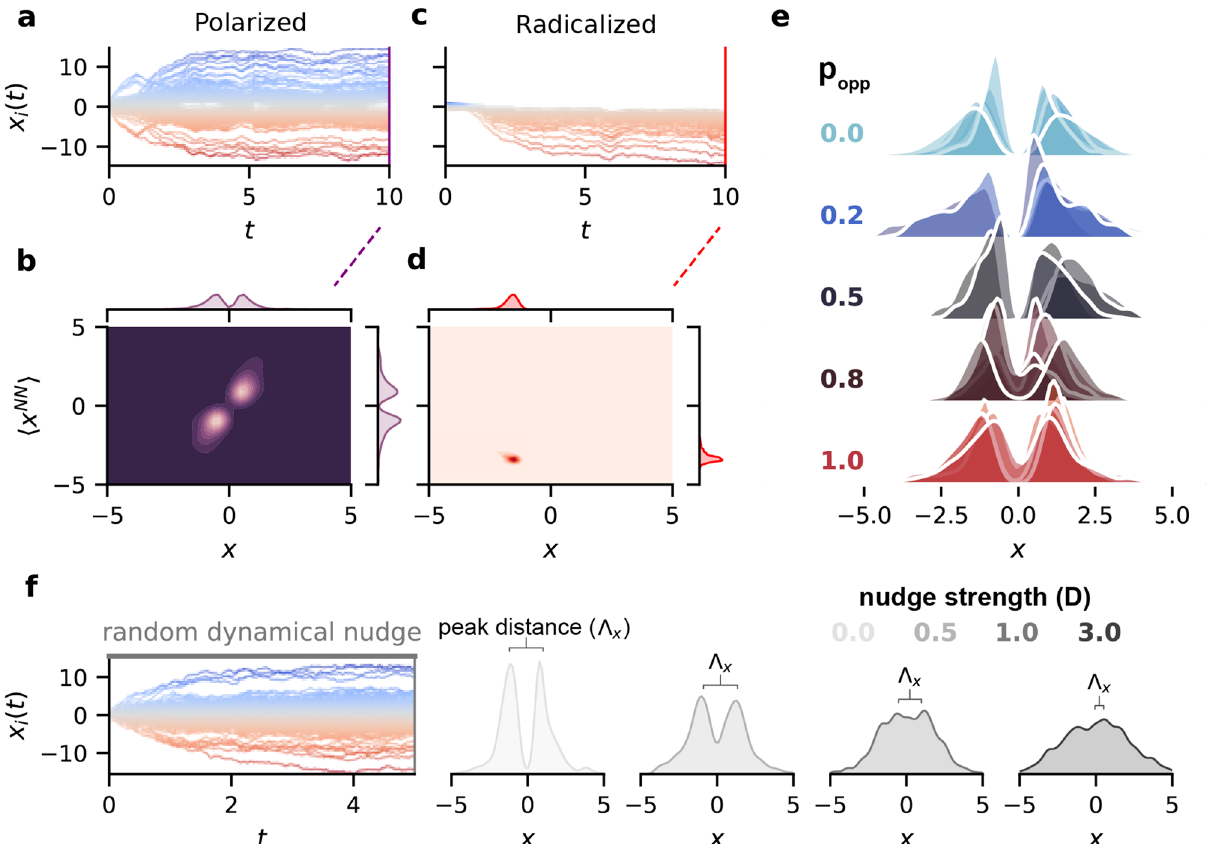
Figure 1. Adding a random dynamical nudge prevents a network from becoming polarized. The time traces 1000 agents for ( a ) polarized ( β 10 , heat maps of 3 ) and ( c ) radicalized ( β 0 ) states. ( b , d ) At t of N = = = = x NN agents’ opinions versus mean of agents’ nearest neighbours ( ) to indicate the formation of echo chambers (cid:31) (cid:30) agents interact with other agents who have similar opinions and the resulting bimodal distribution of opinions for polarized networks. ( e ) p opp represents the probability of randomly flipping the homophily factor ( β ) to instead interact more with those holding opposite opinions. p opp did not appear to be effective and instead 10 (5 simulations individually plotted per p many simulations produced radicalized networks by t opp ). We = introduce a “random dynamical nudge” (RDN, f) that prevents a network of agents from becoming polarized with sufficient strength D . The peak distance (cid:31) x is shown by the width of the brace for each D . Here, the RDN is the Wiener process ξ( t ) . The degree of polarization is indicated by the peak distance ( (cid:31) x ). Other simulation 10 , K 3 , α 3 , and r 0.5 parameters were m = = = =